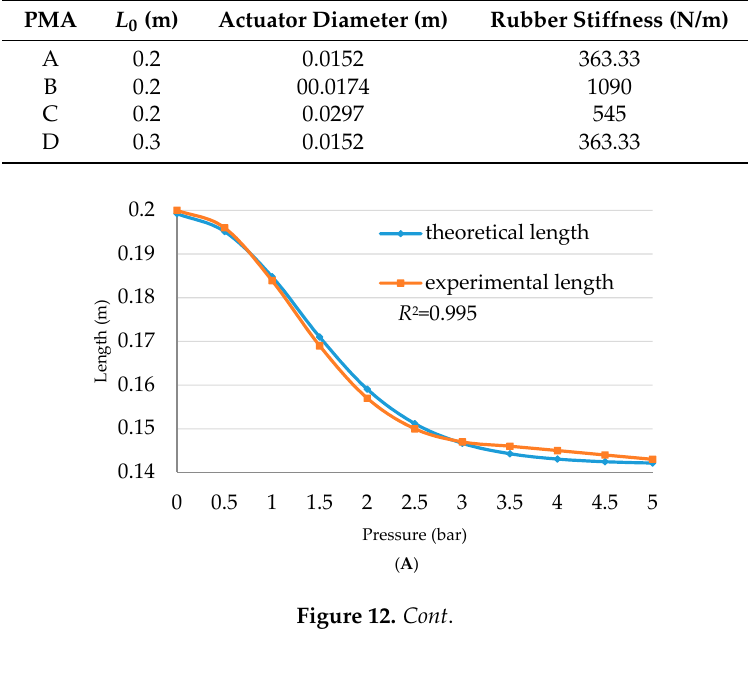
Table 5. The specifications of the contraction PMAs.